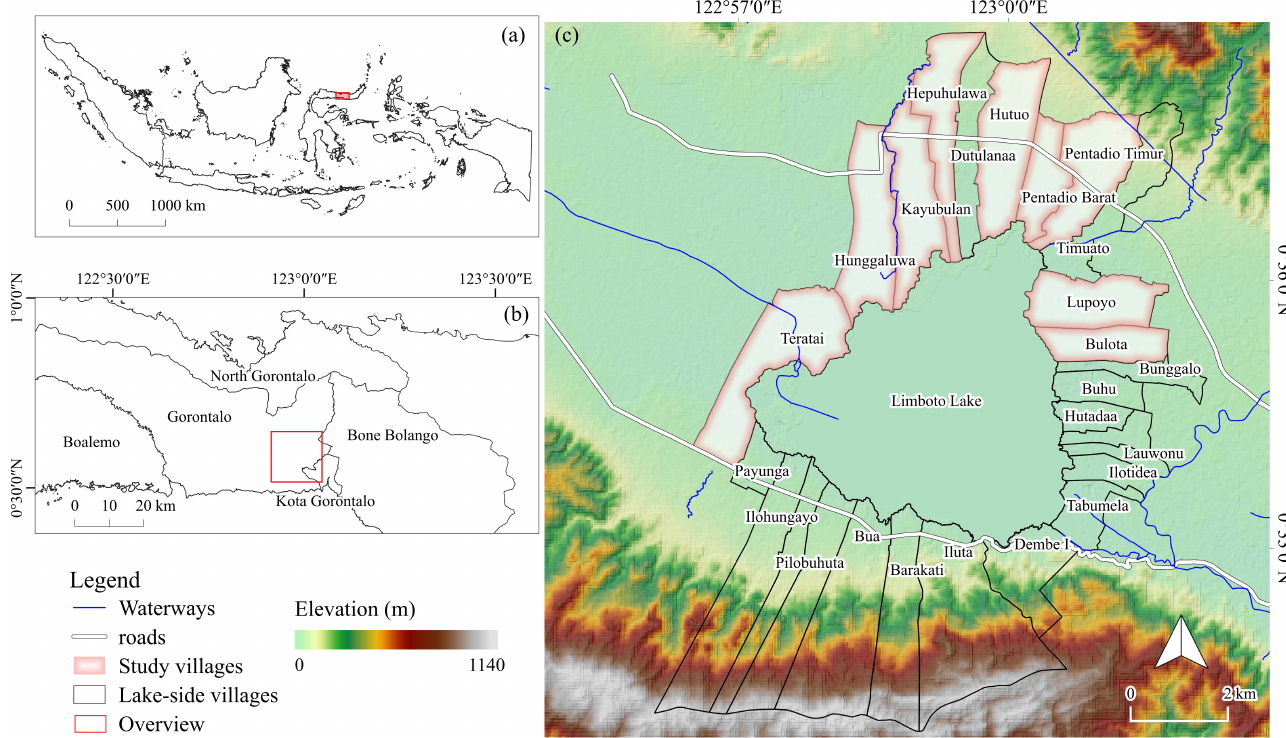
Figure 2. Study area: ( a ) country overview; ( b ) regional overview; ( c ) topographical setting and lake-side